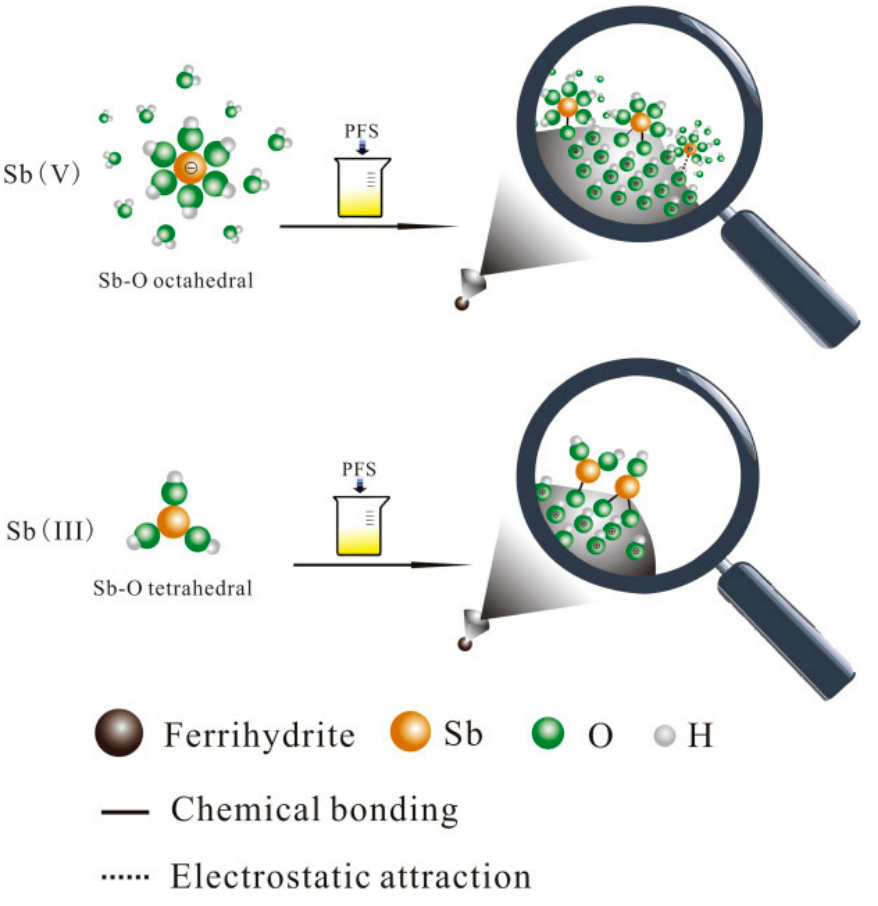
Figure 2. Sb(V) and Sb(III) removal mechanism in the CFS process [32]. Copyright 2018, Elsevier Publishing Group.